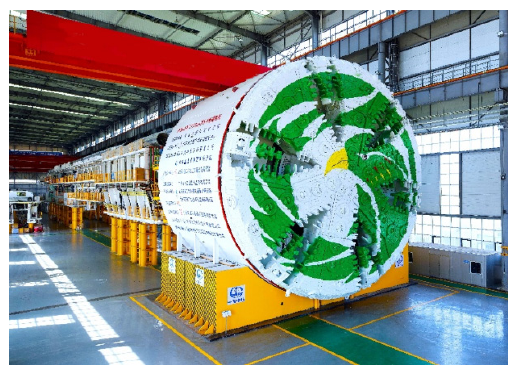
Figure 3. Slurry shield of the Chunfeng tunnel.